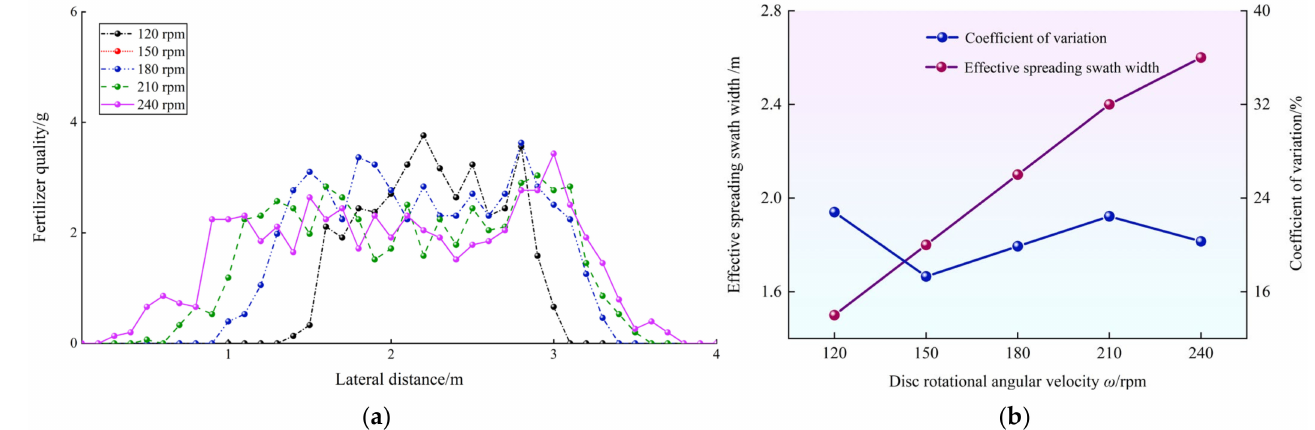
Figure 13. Effects of the disc rotational angular velocity ω . ( a ) Fertilizer quality distribution along the lateral distance; ( b ) variations of effective swath width and C v along with ω .